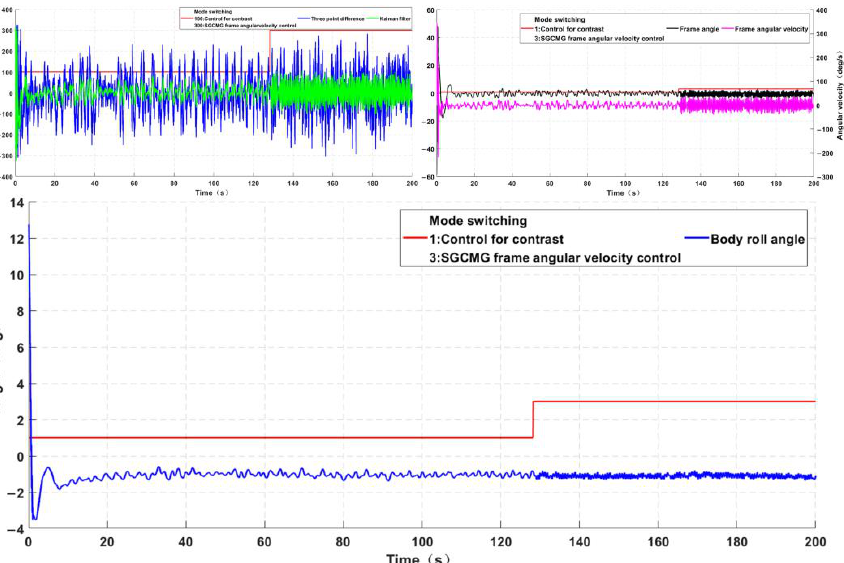
Figure 23. Experimental results: Self-balancing process of the prototype with two controllers at a standstill and no steering angle. standstill and no steering